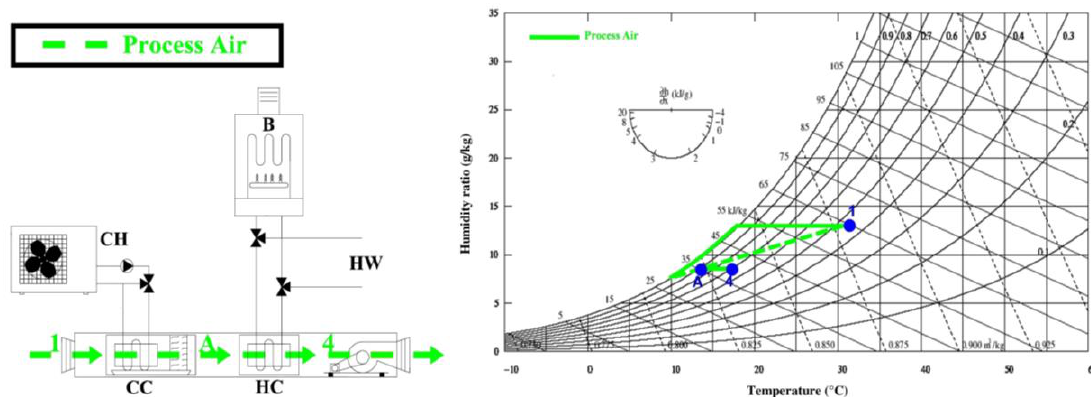
Figure 6. Scheme of the standard AHU and psychrometric diagram.